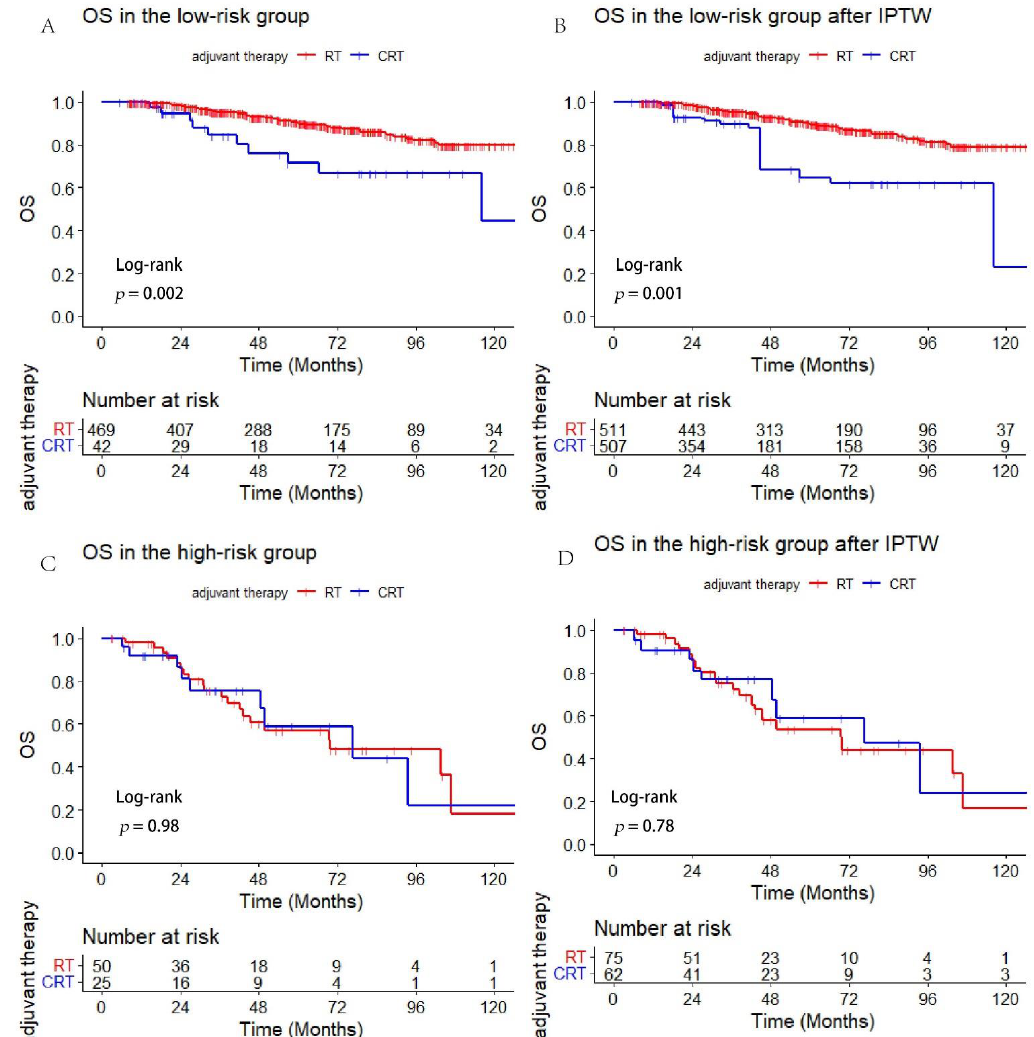
Figure 3. Comparison of OS between adjuvant CRT versus RT alone in the high- and low-risk group (( A ): OS in the low-risk group, ( B ): OS in the low-risk after IPTW, ( C ): OS in the high-risk, ( D ): OS in the high-risk after IPTW) .